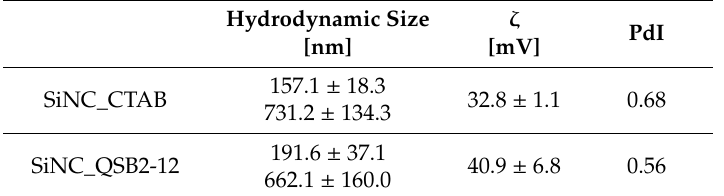
Table 1. Dynamic Light Scattering (DLS) data for synthesized SiNC_CTAB and SiNC_QSB2-12. Hydrodynamic Size